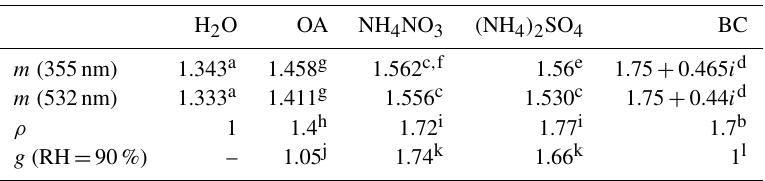
Table 1. Aerosol properties of selected compounds used for the model predictions, the refractive index ( m ) at 355 and 532nm, density ( ρ ), and growth factor.